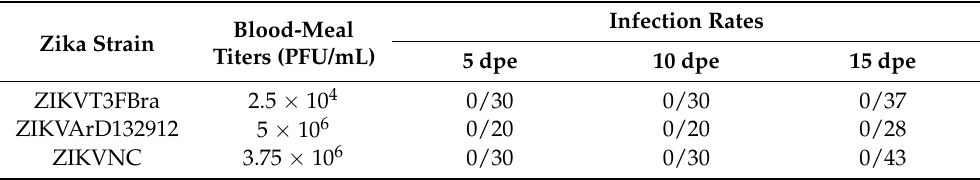
Table 1. Infection rates of C. quinquefasciatus orally exposed to ZIKV strains. Blood-Meal Zika Strain Titers